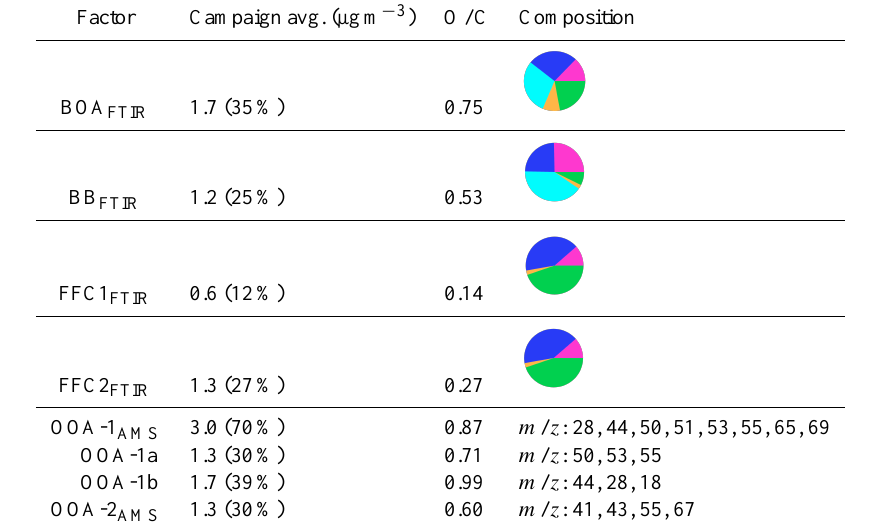
Table 3. Summary of concentration, OM fraction (shown in parentheses), O/C, and composition (organic functional group composition of FTIR factors and prevalent m / z signatures of AMS factors) for FTIR and AMS factors. Organic functional groups from FTIR, including alcohol (pink), alkane (blue), carboxylic acid (green), amine (orange), and carbonyl (teal).